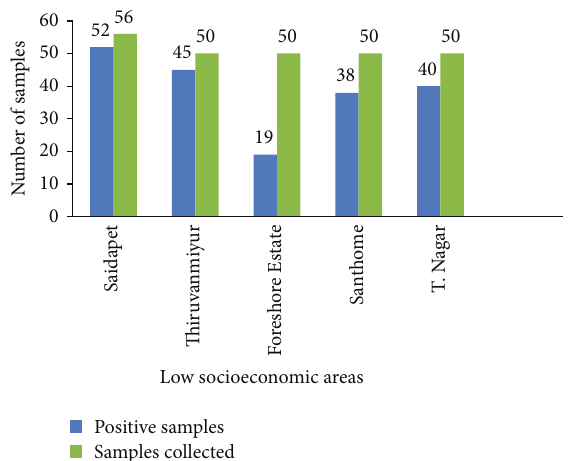
Figure 2: Distribution of samples in low socioeconomic areas from south Chennai.